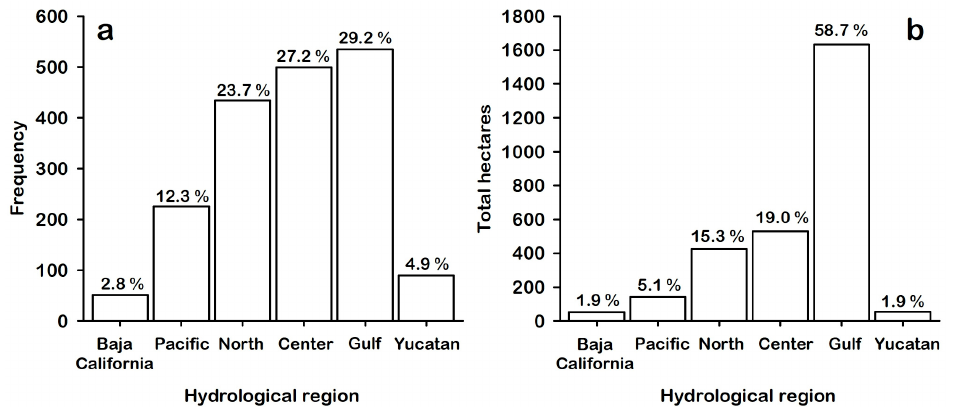
Figure 6. Distribution of ( a ) number and ( b ) surface of lacustrine blue spaces by hydrological region. Table 1. Descriptive statistics for lacustrine blue spaces’ number and surface by hydrological region.